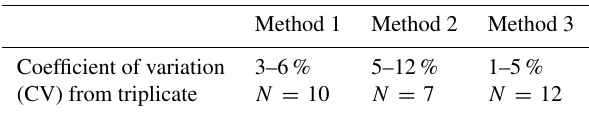
Table 1. Coefficient of variation (CV) of OP Total-DTT for three ex- traction